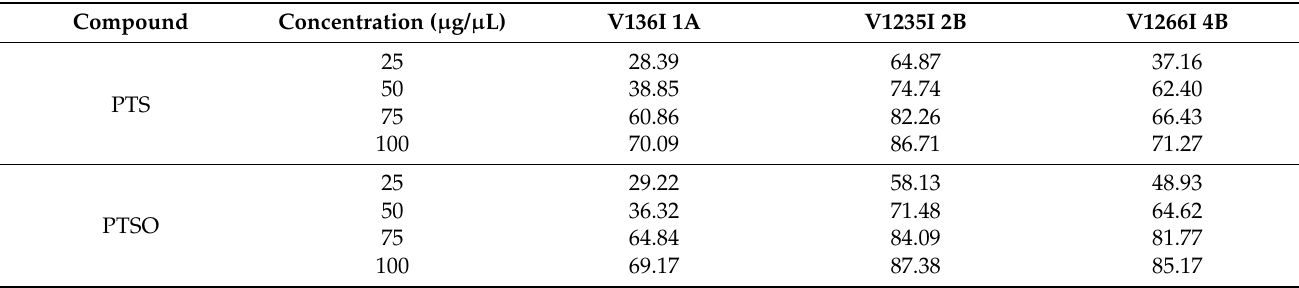
Table 5. Percentage of mycelial growth inhibition of Verticillium dahliae isolates at different concentration of PTS and PTSO: control group; 25; 50; 75 and 100 µ g/mL.